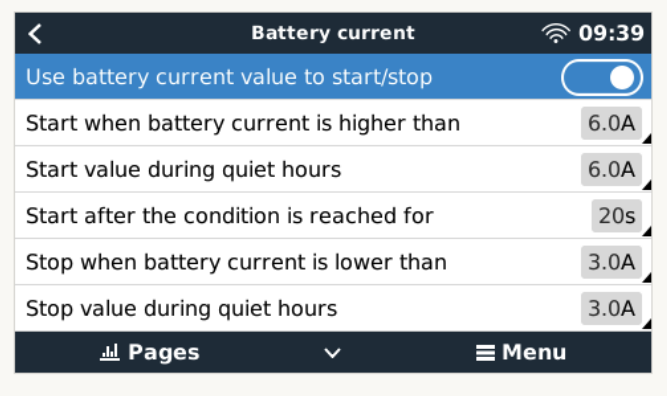
Figure 17. Condition configuration based on current.